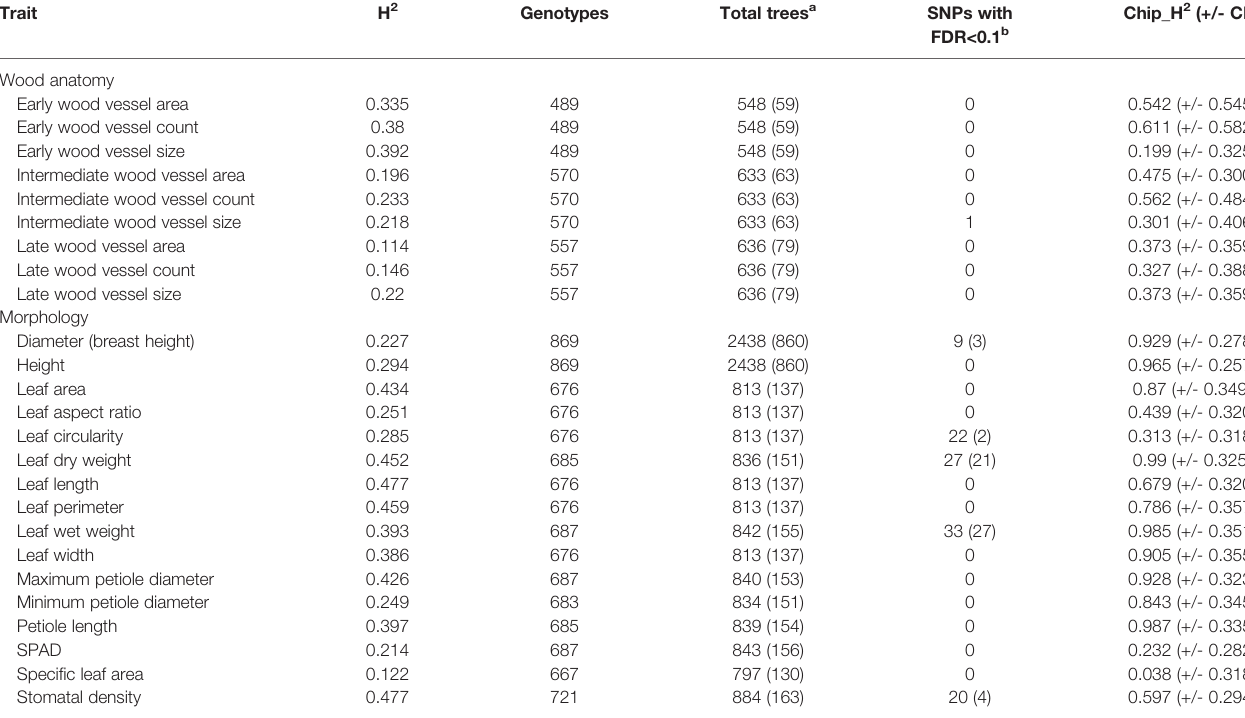
TABLE 1 | Broad-sense heritability estimates ( H 2 ) and the number of SNP-trait associations for wood anatomical and morphological traits in P. trichocarpa. Trait